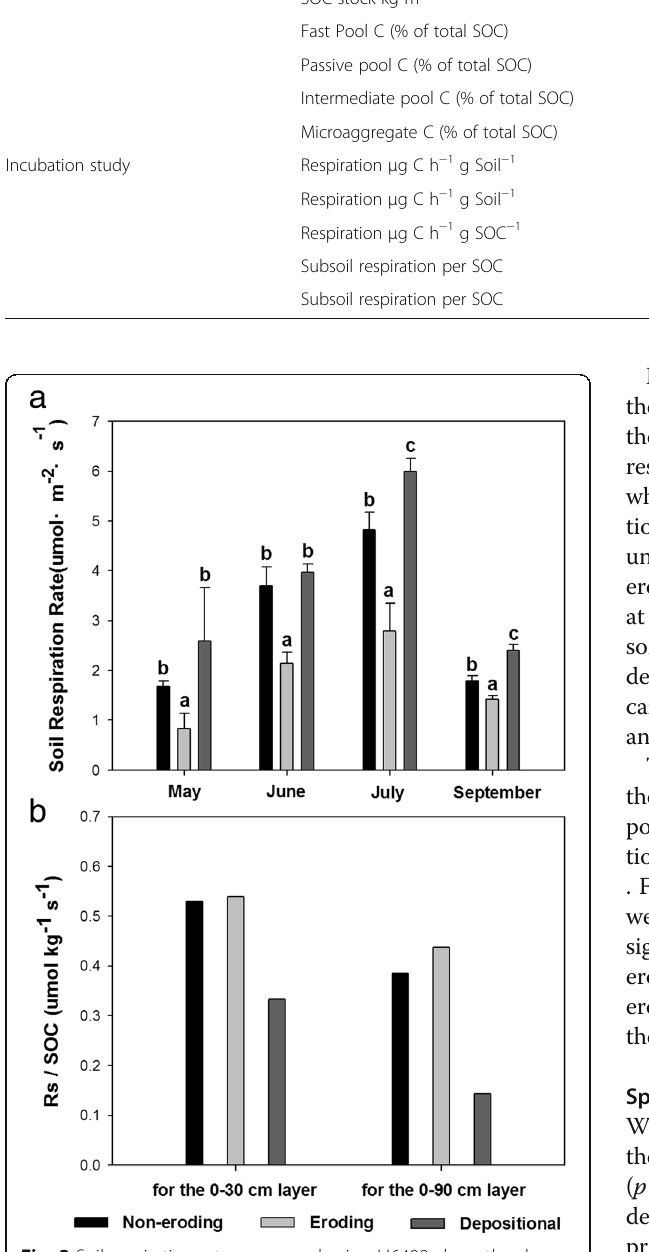
Fig. 3 Soil respiration rates measured using LI6400 along the slope in May, June, July, and September ( a ), and ratios of the soil surface respiration fluxes (Rs) to the SOC inventory along the slope for the 0 – 30 cm layer and for the 0 – 90 cm layer ( b ). The same letter indicates no significant difference between the geomorphic positions ( p < 0.1, tested for May to September